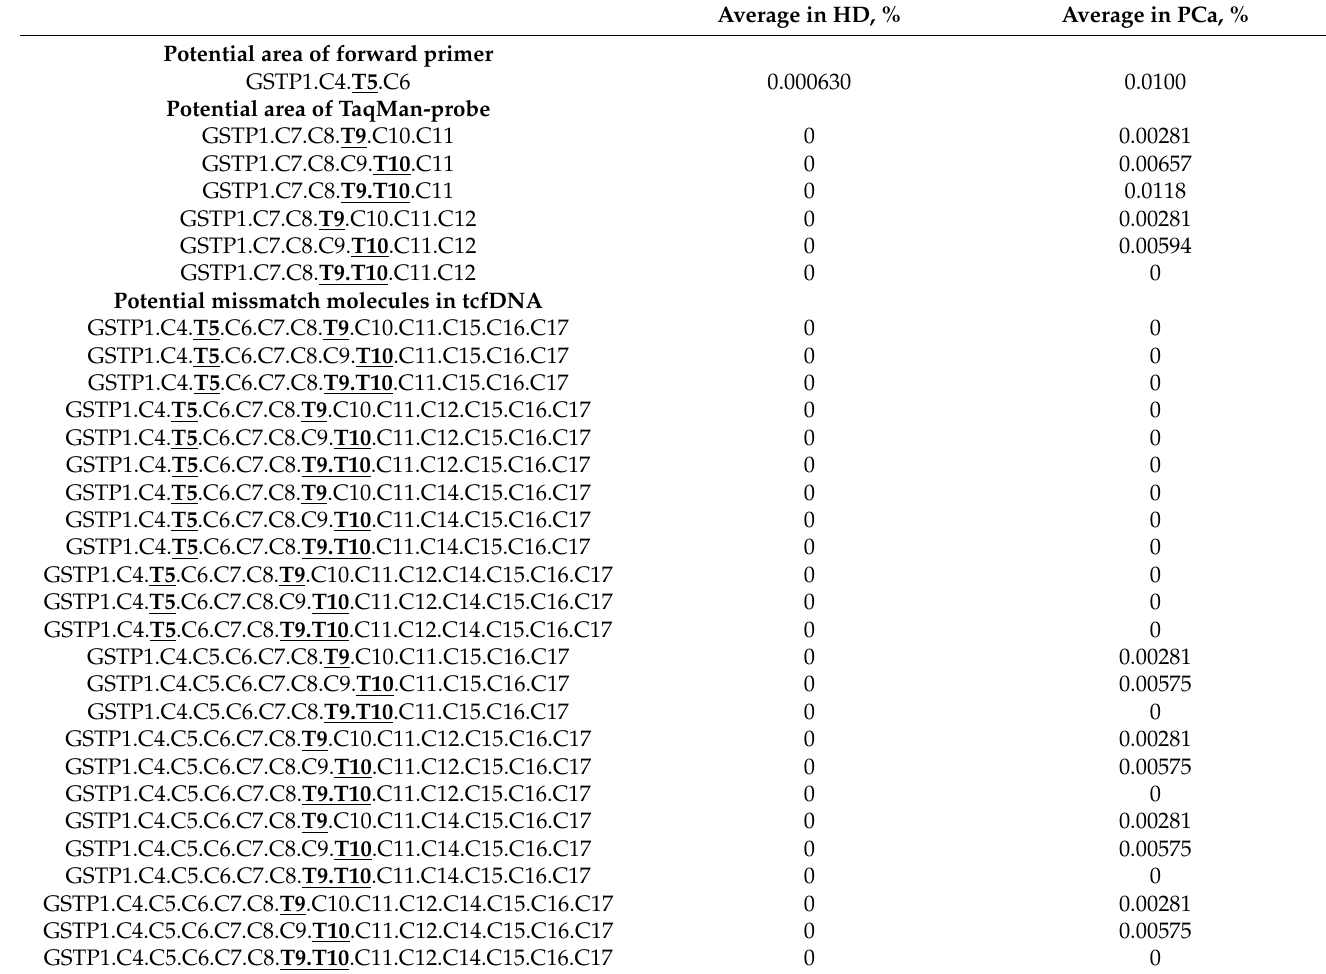
Table 8. List of possible additional combinations of cytosines for the “creation” of PCR systems. Average in HD,